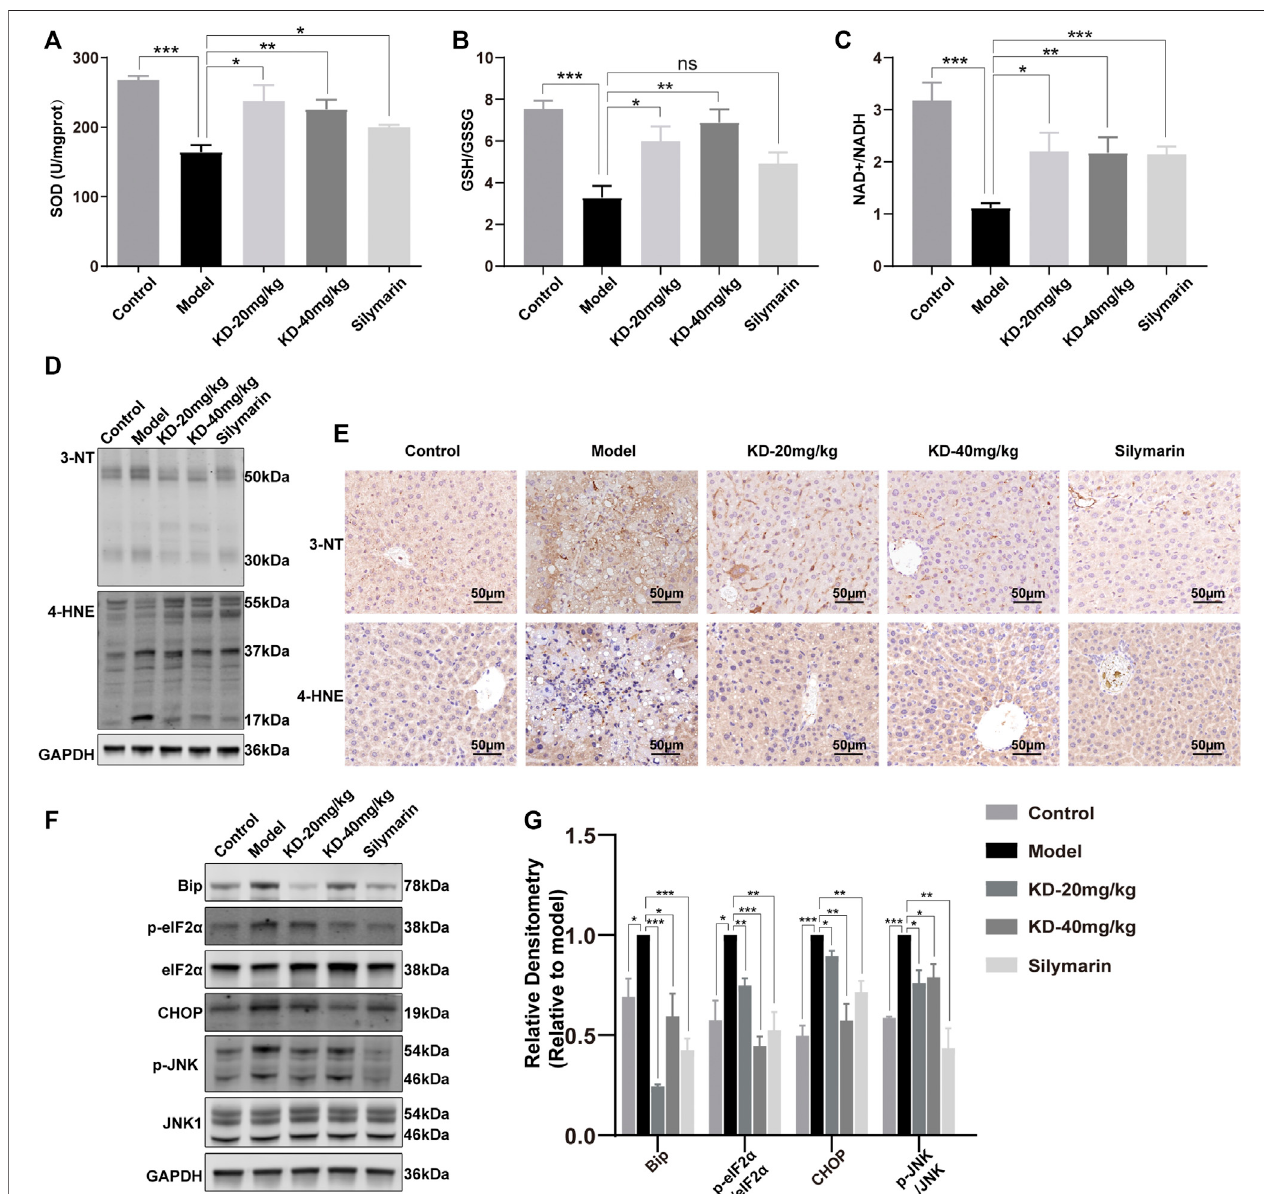
FIGURE 5 | Effects of KD on oxidative stress and ER stress in mice. (A) SOD activity in liver homogenates. (B) Liver GSH to GSSG ratios. (C) Liver NAD + to NADH ratios.( n (cid:1) 5 – 7). (D) Liver3-NTand4-HNEexpressiondeterminedbywesternblotting. (E) Immunohistochemistrystainingof3-NTand4-HNEinthemiceliver.Scalebar: 50 µm. (F) ExpressionofERstress-relatedproteinsdeterminedbywesternblotting. (G) Quantitativeanalysisofproteinexpression( n (cid:1) 3).GAPDHwasusedasaloading control. Data represent the mean ± SEM. ns, not signi fi cant. * p < 0.05, ** p < 0.01, *** p < 0.001 vs. the model group.